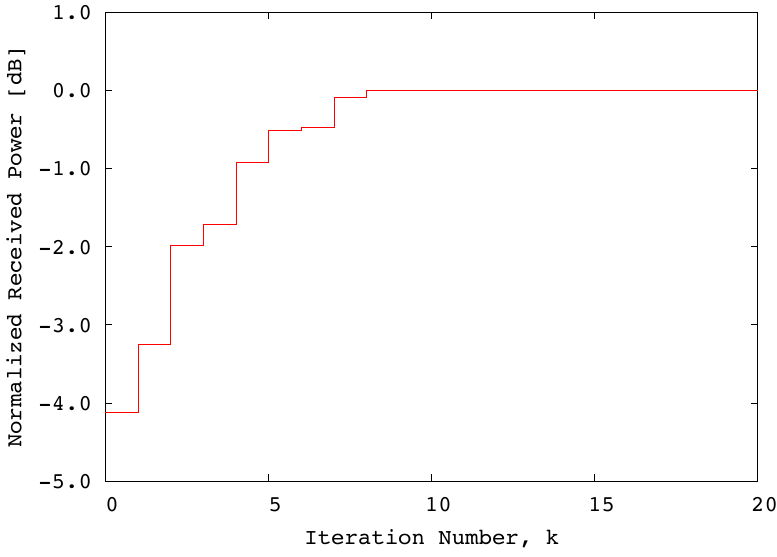
Figure 8. Behaviour of the received power versus iteration number of the control